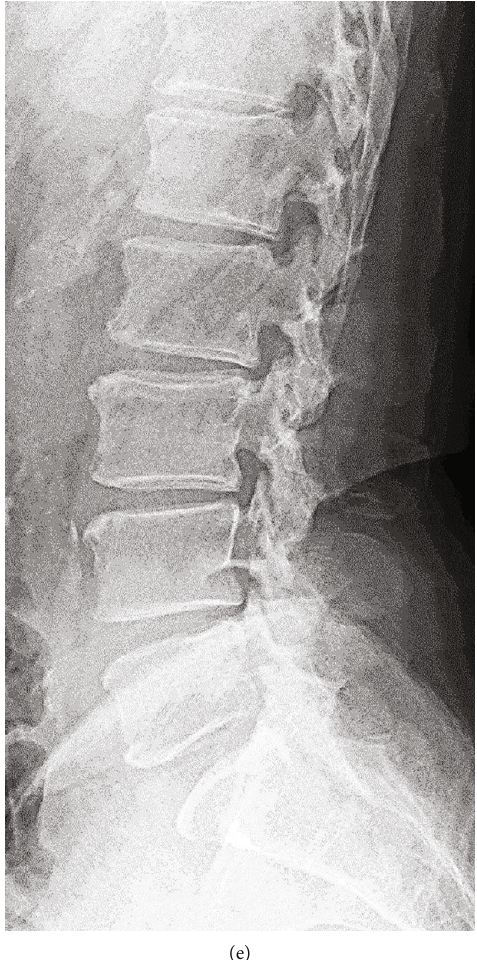
Figure 3: Condoliase injection procedure and fi ndings after treatment. In the prone position, a 12cm spinal needle was inserted from the left lateral side under fl uoroscopy, advanced to the center of the L4/5 disc (a, b), and the condoliase was injected. Two months after treatment, lumbar T2-weighted magnetic resonance imaging showed that the disc herniation at L4/5 had signi fi cantly decreased in size (c, d). Although progression of the degree of a ff ected-disc degeneration was observed (c), standing radiography revealed that the L4/5 disc height was the same as that before treatment